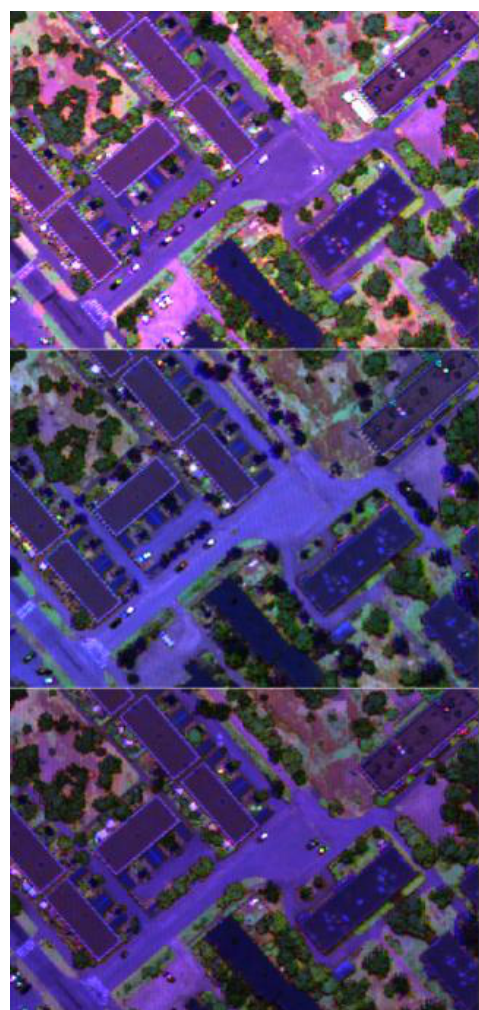
Figure 5. First pulse intensity images (20 cm raster) from August 2015 (top), May 2016 (middle) and June 2016 (bottom). In all images, the histogram stretching is the